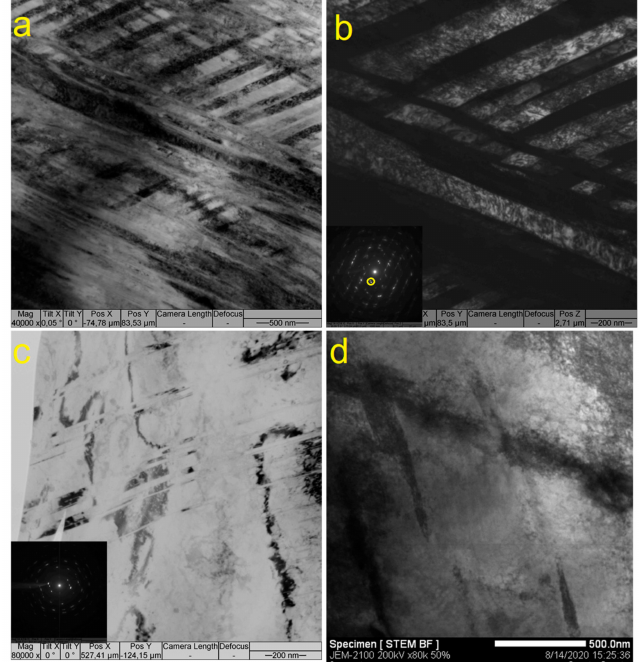
Figure 13. Bright ( a ) and dark field ( b ) TEM images of two intersecting deformation twin systems in sample 1-2 ( a , b ) and thin twins as well as twin-free areas 1-1 ( c , d ). The dark field images were obtained using the twin reflections shown in circles in corresponding SAED